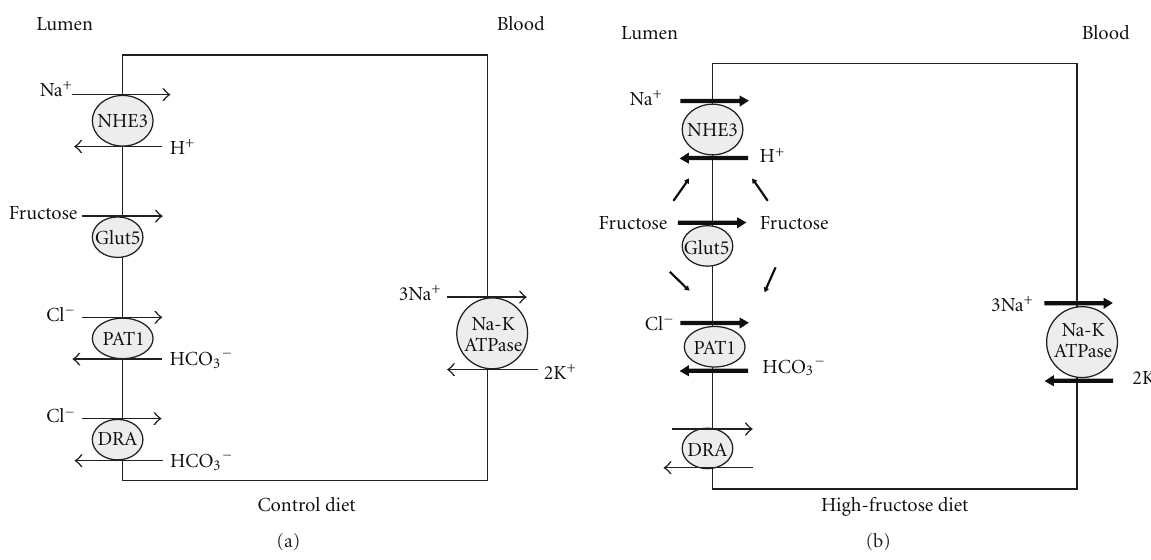
Figure 3: The role of fructose and Glut5 in fructose absorption and fructose-stimulated salt absorption in the small intestine. Luminal fructose is predominantly absorbed via Glut5 action and stimulates PAT1 and NHE3, therefore enhancing salt absorption in the jejunum. The stimulatory e ff ect of luminal fructose on salt absorption in jejunum was completely abrogated in Glut5 null mice (see